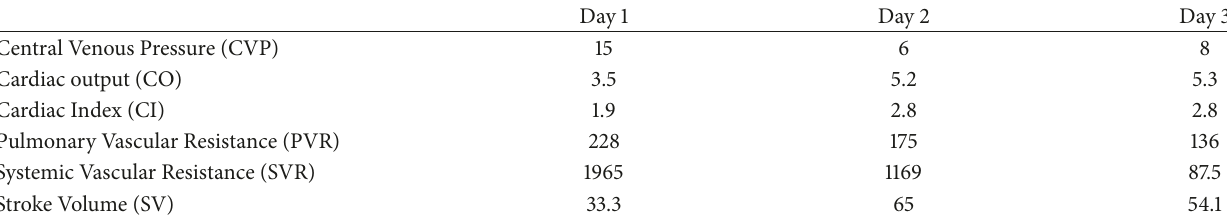
Table 1: Right heart catheterization results and corresponding